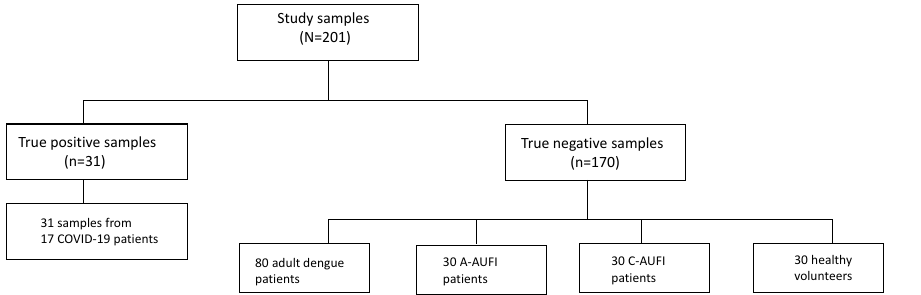
Figure 1. Serum samples used in the study. A-AUFI, adults with undifferentiated febrile illness; C-AUFI, children with acute undifferentiated febrile